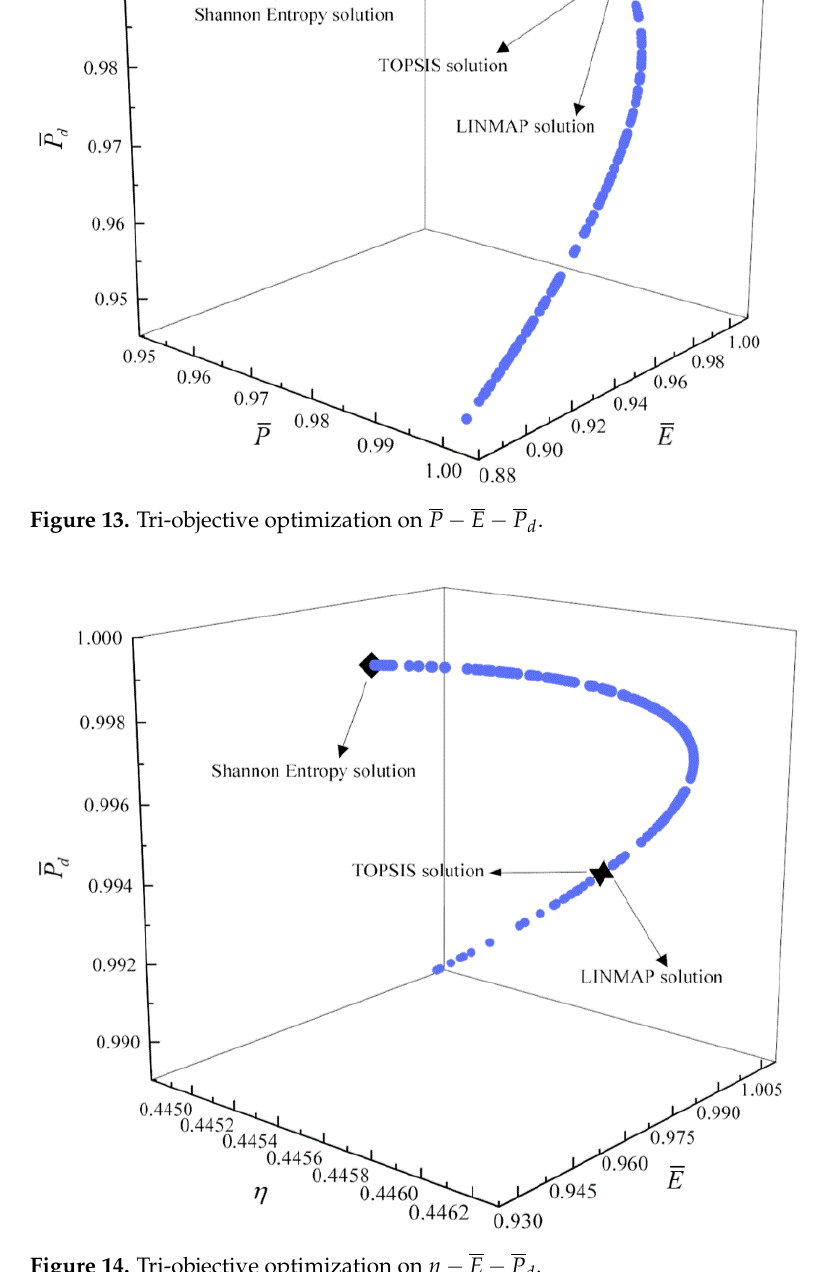
Figure 14. Tri-objective optimization on η − E − P d